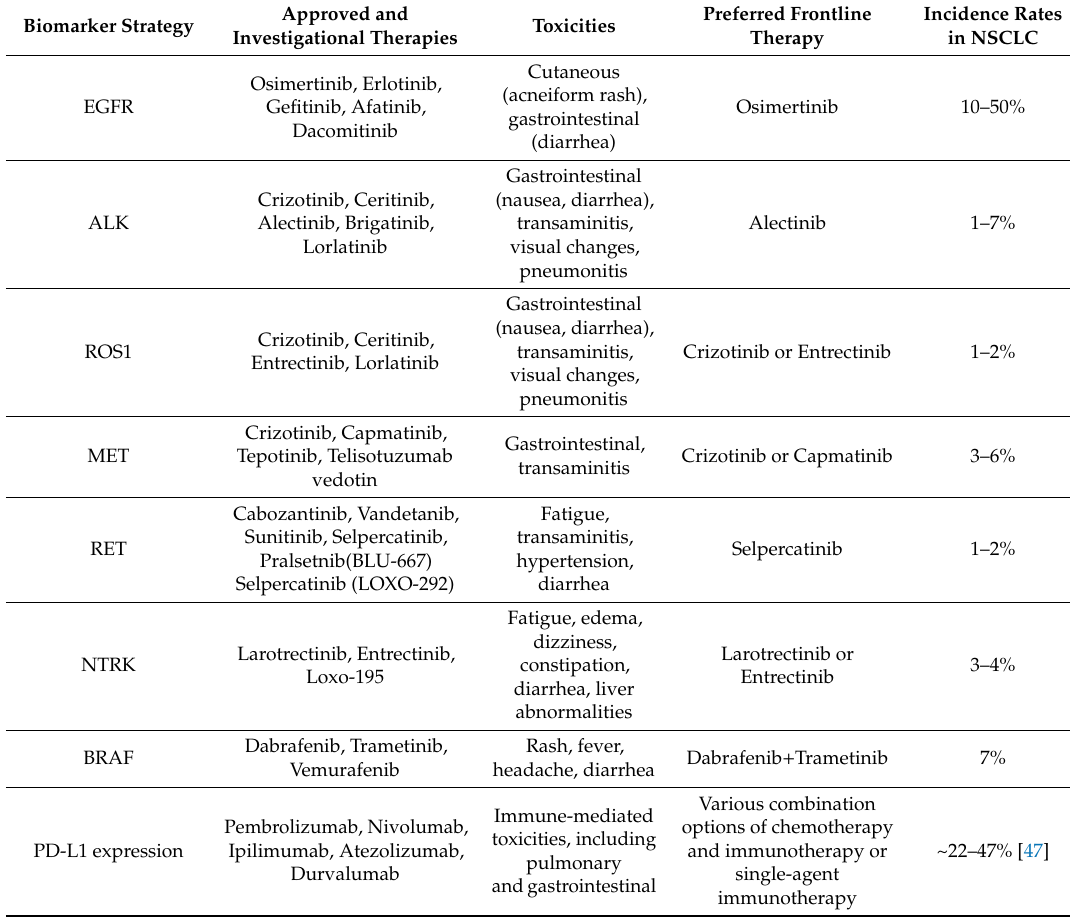
Table 1. Actionable targets in lung cancer and available